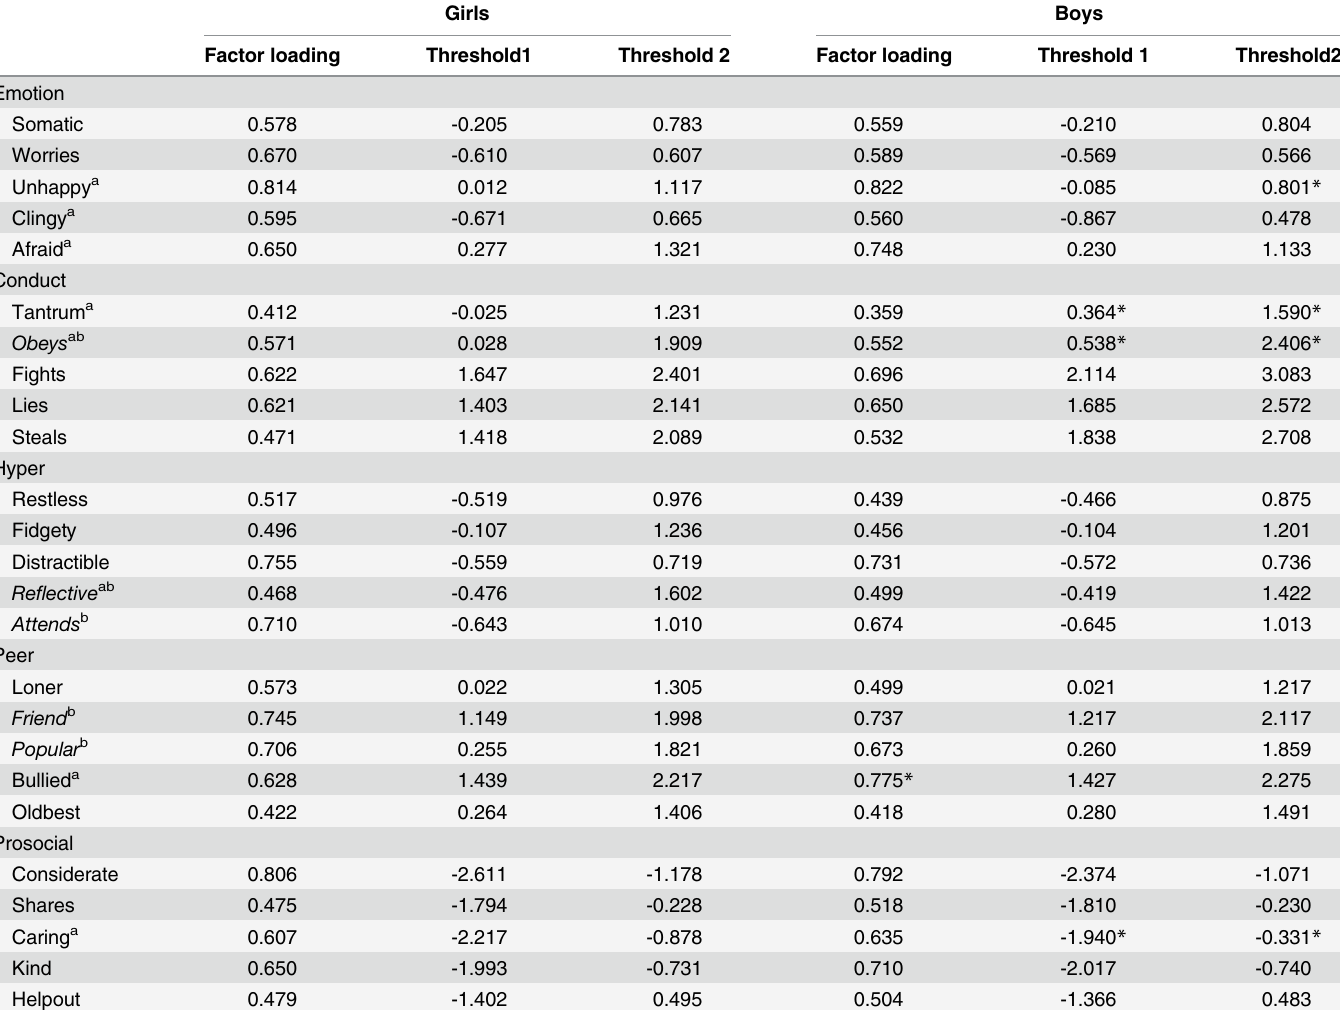
Table 2. Standardized factor loadings and thresholds based on confirmatory factor analysis for the SDQ five-factor model (n =